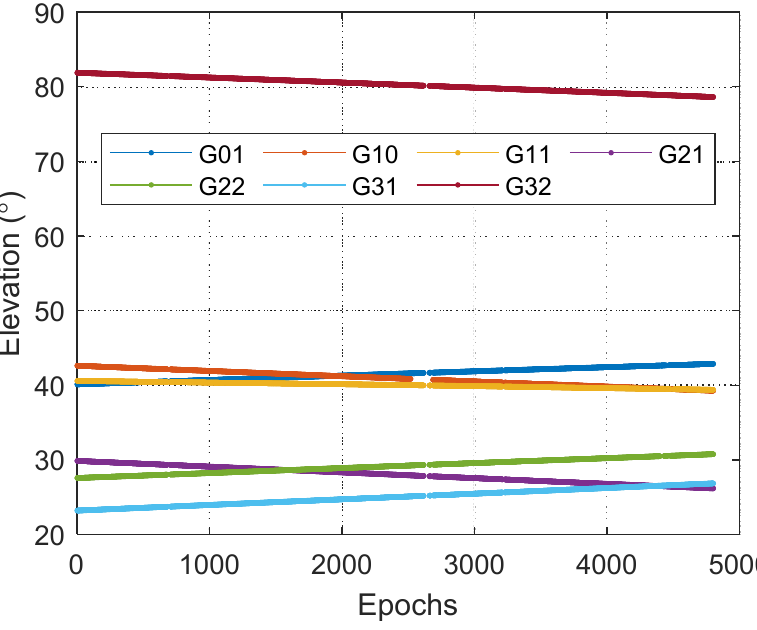
Figure 7. Elevation angles of the selected satellites.